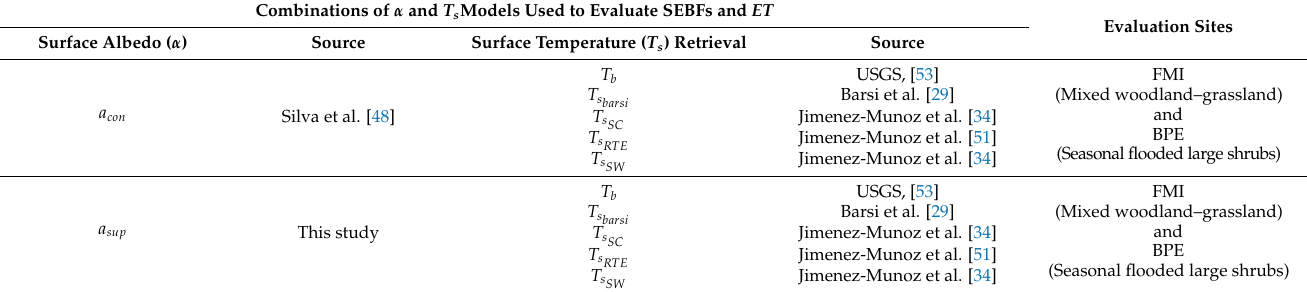
Table 2. Summary of model combinations used to evaluate the effects of the surface albedo estimated by the conventional model ( a con ) and the model developed in this study ( a sup ) and the surface brightness temperature ( T b ), and the surface temperature retrieved by the Barsi model ( T s ), the single-channel model ( T s ), the radiative transfer equation model SC barsi ( T s ), and the split-window model ( T s ) on surface energy balance and evapotranspiration. RTE SW Combinations of α and T s Models Used to Evaluate SEBFs and